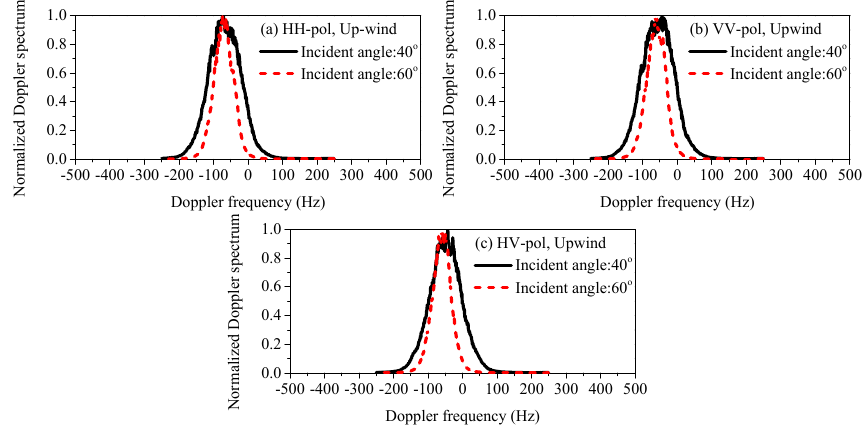
Figure 13. Comparison of Doppler spectrum at Ka-band for different incident angles and polarizations. ( a ) HH polarization; ( b ) VV polarization; ( c ) HV polarization.